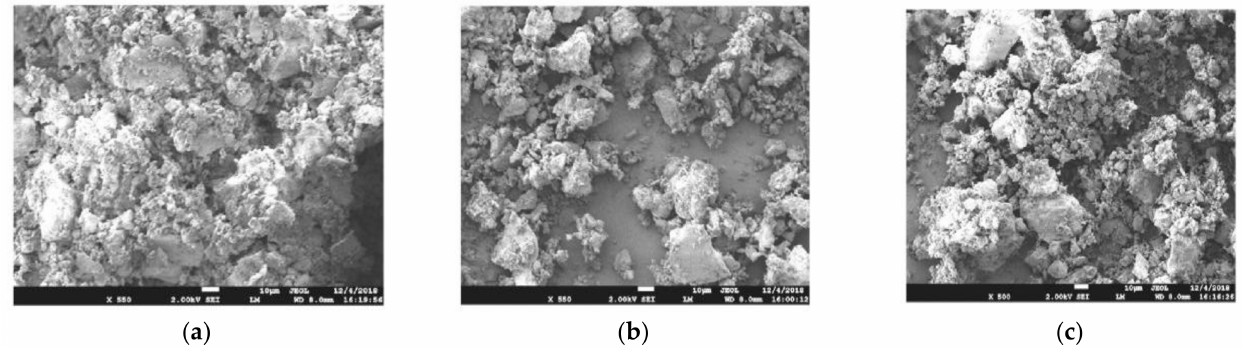
Figure 6. SEM images of different types of RP [54]. ( a ) RCP; ( b ) RBP; ( c )